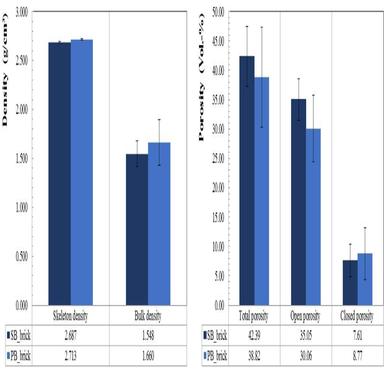
Filling of the RBAs through an advanced spray process .